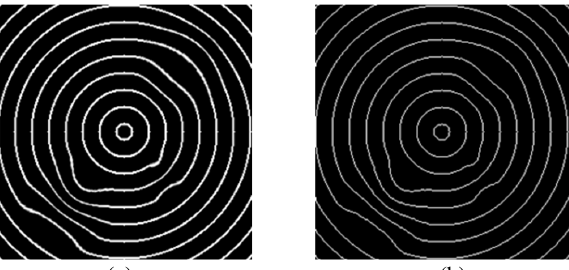
Fig. 3. Two processed images from transmitted imaging of the concentric circles pattern through a defective lens: (a) the binarized image; (b) the thinned image